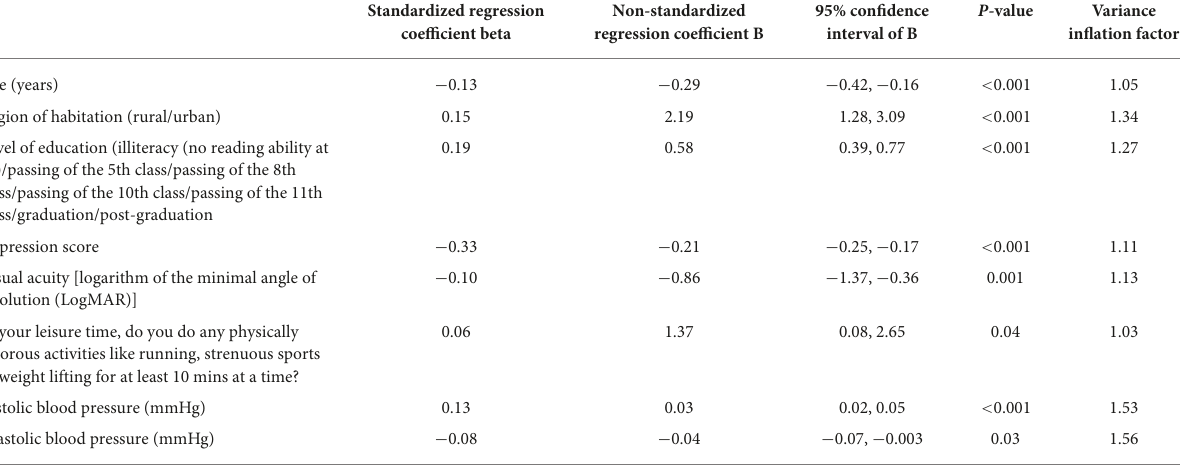
TABLE 2 Associations (multivariable analysis) between the Mini-Mental State Examination (MMSE) score and other parameters in the Ural Very Old